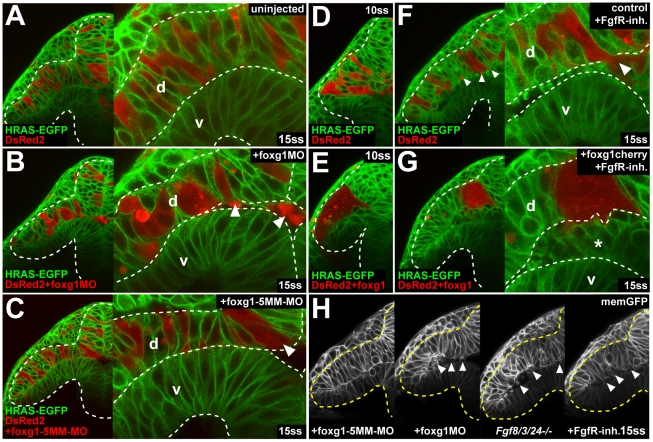
Foxg1 is required for cell cohesion in the optic vesicle.(A–C) Live images of a DsRed2-expressing cell clone from a noninjected control donor (A), a foxg1-morpholino–injected donor (B), and a foxg1-mismatch-control-morpholino–injected donor in a Tg(Bactin:HRAS-EGFP)vu119 host embryo (C) at 15ss (right: high magnification view of the dorsal and ventral leaflet in the region of the proximal optic vesicle, arrowheads: delaminating cells). (D and E) Live images of a DsRed2-expressing cell clone from a noninjected control donor (D) and a foxg1-RNA–injected donor (E) in a Tg(Bactin:HRAS-EGFP)vu119 host embryo at 10ss. (F and G) Live images of a DsRed2-expressing cell clone from a noninjected control donor (F) and a foxg1-injected donor (G) in a Tg(Bactin:HRAS-EGFP)vu119 host embryo in the presence of FgfR-inhibitor at 15ss (right: high magnification view of the dorsal and ventral leaflet in the region of the proximal optic vesicle, arrowheads in [F] and asterisk in [G]: delaminating cells). (H) Live images of cell delamination (arrowheads) in a foxg1-mismatch-control-morpholino–injected embryo, a foxg1-morpholino–injected embryo, an fgf8/3/24−/− embryo, and an embryo after FgfR.-inh. treatment at the 15ss stage, coinjected with memGFP RNA (from left to right). Orientation: cross-sections, dorsal to the top and lateral to the left. Dotted lines: neural tube boundary. d, dorsal optic vesicle leaflet; v, ventral optic vesicle leaflet.